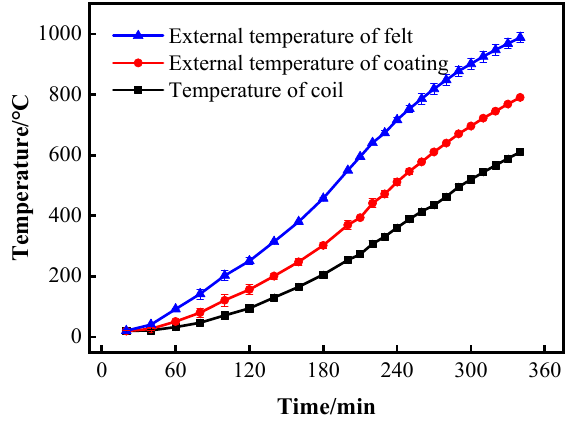
Figure 9. Induction coil temperature after arranging 5 mm heat insulation coating and 5 mm insulation felt.